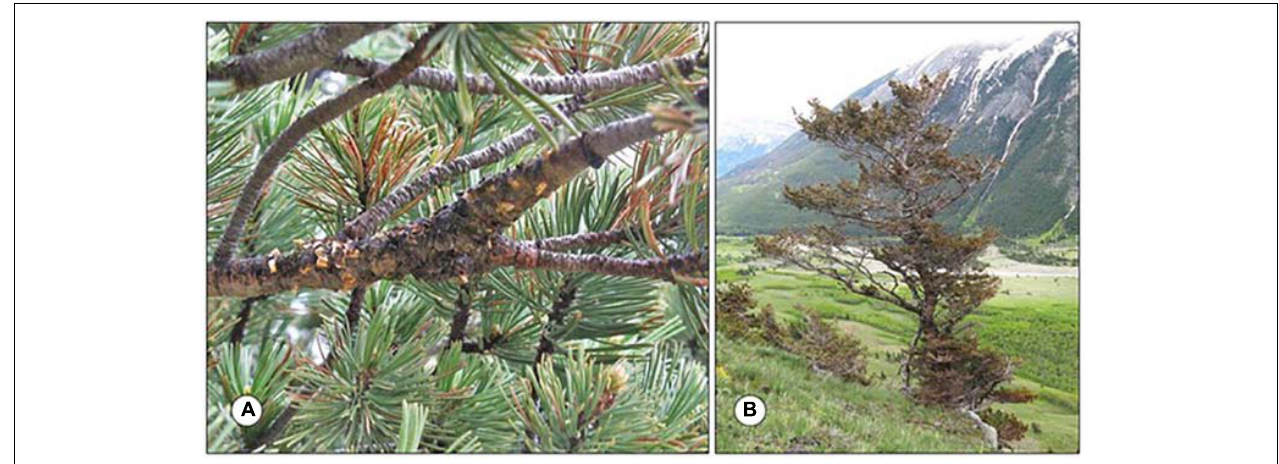
FIGURE 3 | Whitebark pine ( Pinus albicaulis ) infected by Cronartium ribicola in southern Alberta. (A) Infected branch with ruptured aecia from which aeciospores have been released. (B) Solitary whitebark pine infected by C. ribicola . Photos, Tod